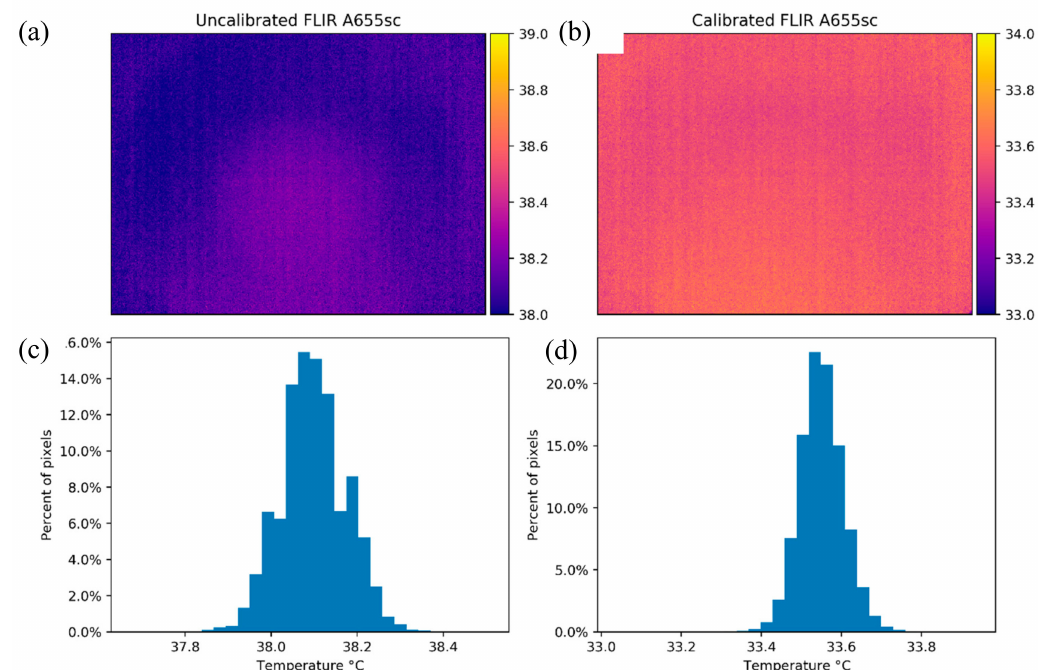
Figure 6. Temperature maps and histograms for the FLIR A655sc camera while looking at the black body with a temperature of 34.28 ◦ C. Panels ( a ) and ( c ) show the results before the calibration process and panels ( b ) and ( d ) depict the results of the same image after applying the calibration equation to each pixel in the whole